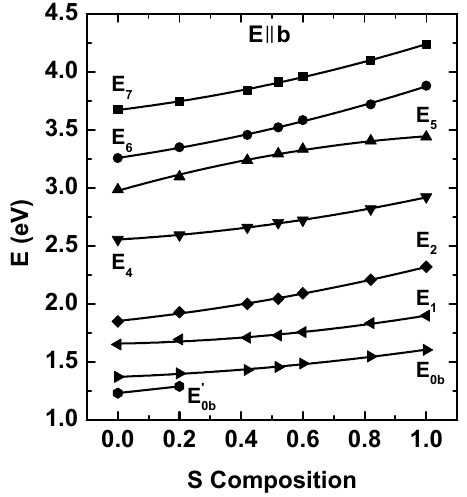
Figure 13. As Figure 12, but for the armchair direction. Table 4. As Table 3, for the armchair Table 3. Fitted parameter values of quadratic equations for allowing composition dependences of the CP energies along the zigzag direction to be determined.